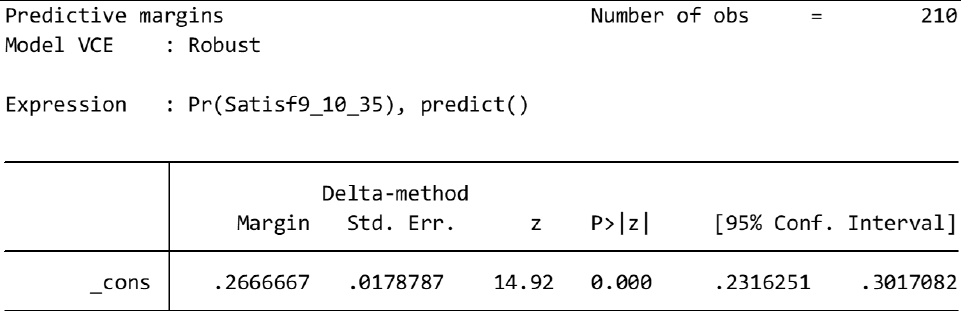
Figure 2. Predictive Margins Model 1.